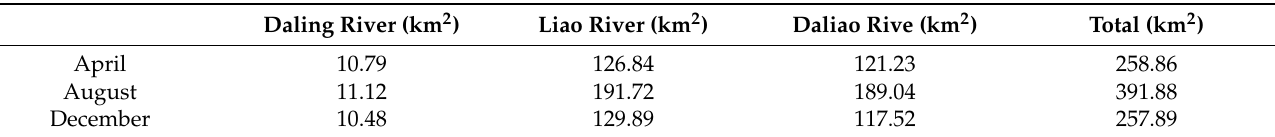
Table 3. Major rivers into the sea corresponding to the sea COD more than the Class I sea water quality standard range.